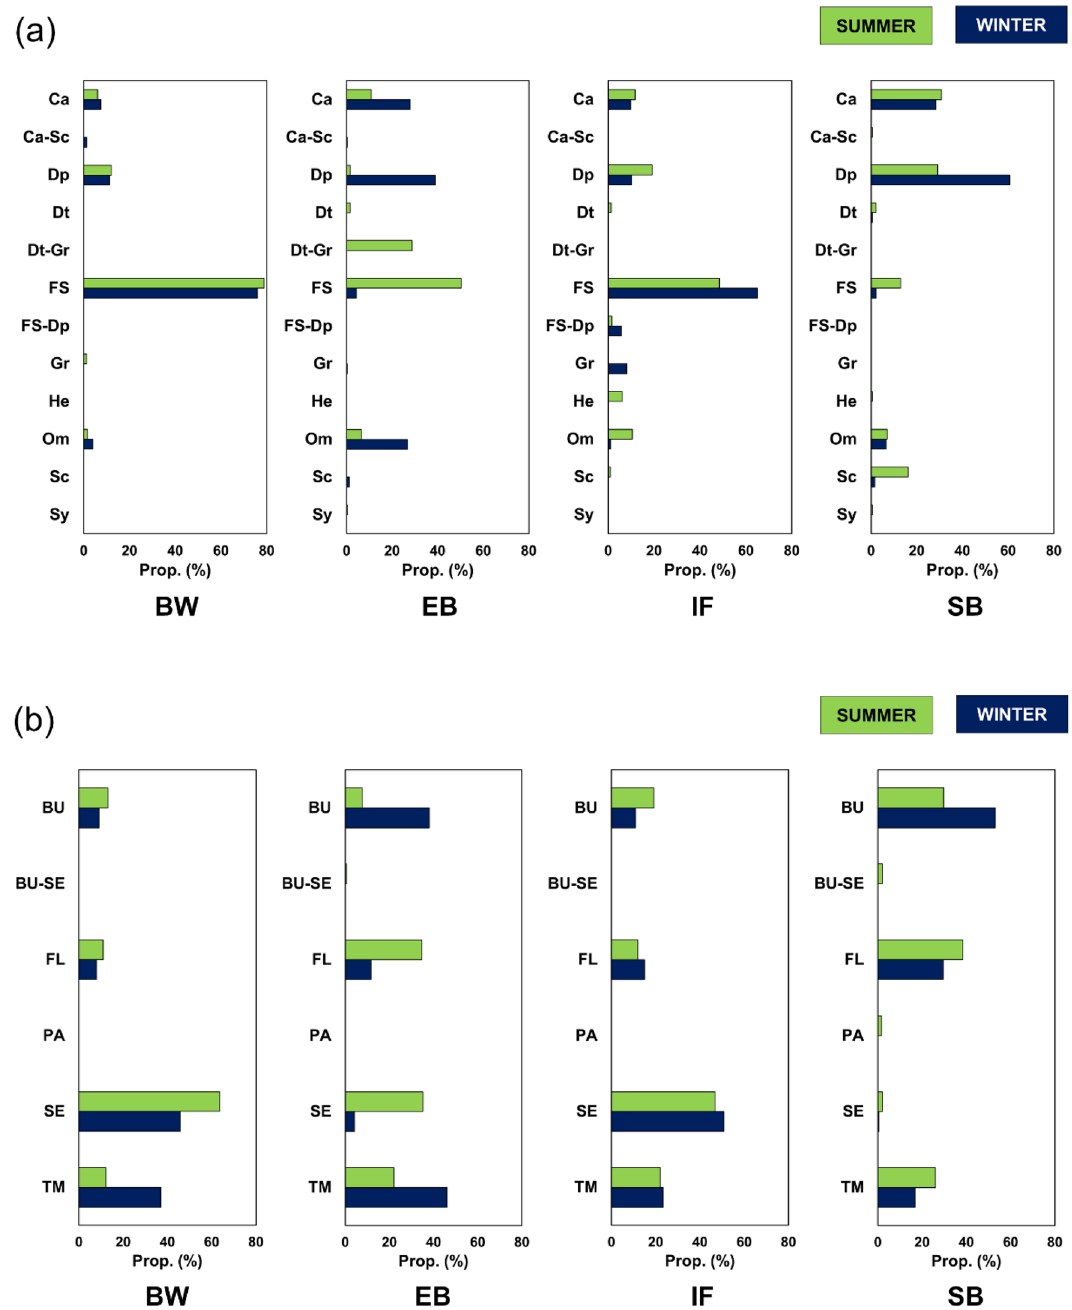
Figure 5. Relative abundance of ( a ) primary feeding types and ( b ) common life forms. Functional groups are abbreviated as follows: Primary feeding types: Ca carnivore, Dp deposit feeder, Dt detritus feeder, FS filter/ suspension feeder, Gr grazer, He herbivore, Om omnivore, Sc scavenger, Sy symbiont. Common life forms: BU burrowing, FL free-living, PA parasite, SE sedentary, TM tube/mucus-sheath building. Habitat abbreviations are as shown in Fig.